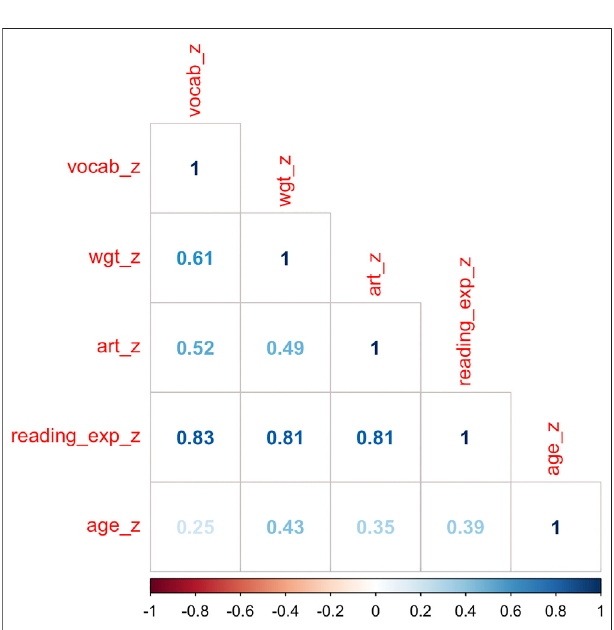
FIGURE 7 | Correlation (Spearman ’ s ρ ) of scores on the vocabulary task (vocab_z),theWordsthatGoTogethertask(wgt_z),theauthorrecognitiontask (art_z), the overall reading experience metric (reading_exp_z), and age